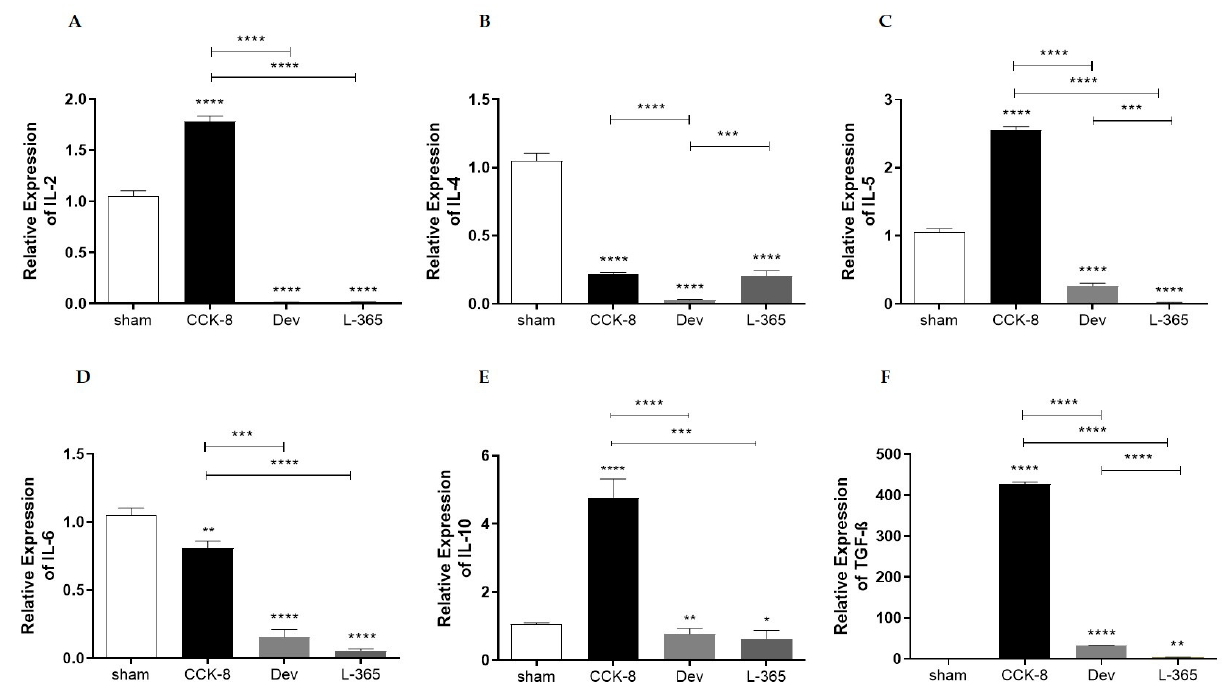
Figure 4. Relative expression of interleukins (ILs) in lamina propria cells of the following groups: sham, CCK8, devazepide, and L365,260. ( A ) IL-2, ( B ) IL-4, ( C ) IL-5, ( D ) IL-6, ( E ) IL-10 and ( F ) trans- forming growth factor- β (TGF- β ). The results from one representative experiment (from three repli- cates) with eight mice per group are expressed as the mean and standard deviation (SD). * p < 0.05, ** p < 0.01 *** p < 0.001 and **** p < 0.0001 upon column comparisons vs. control group or upon line comparisons among the CCK8, devazepide and L365,260 groups.